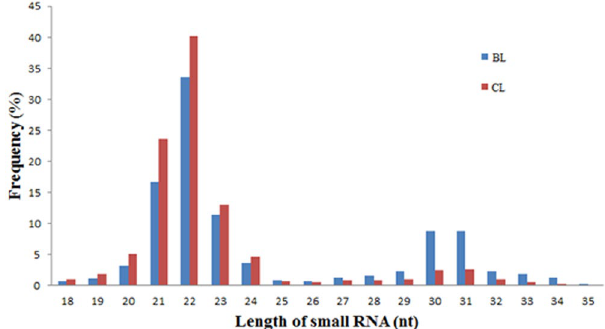
Figure 2. Length distribution of small RNAs in BL and SL libraries.